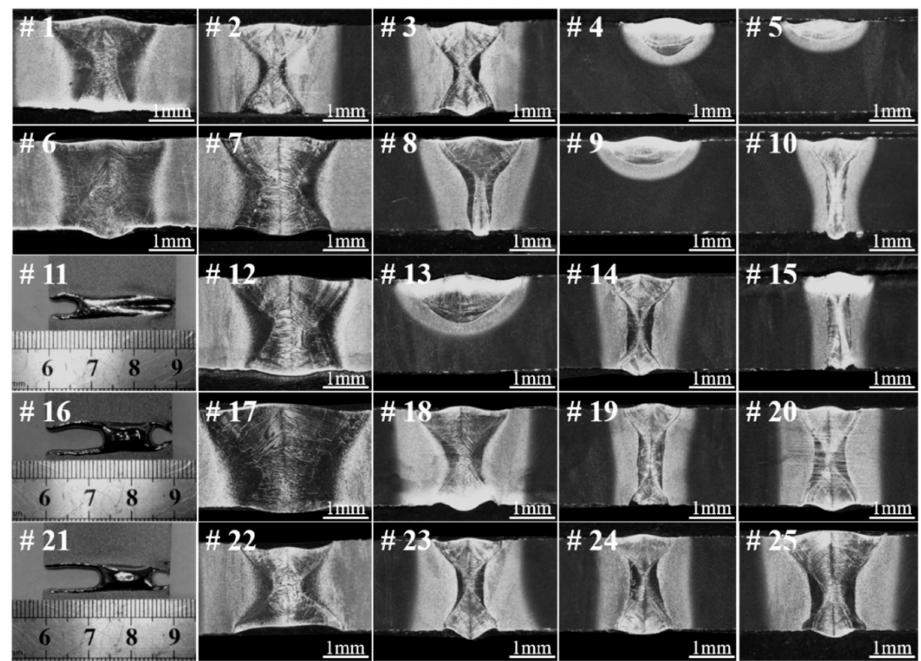
Figure 3. Morphologies of cross-sections of welded joints obtained by conducting welding experiments according to Table